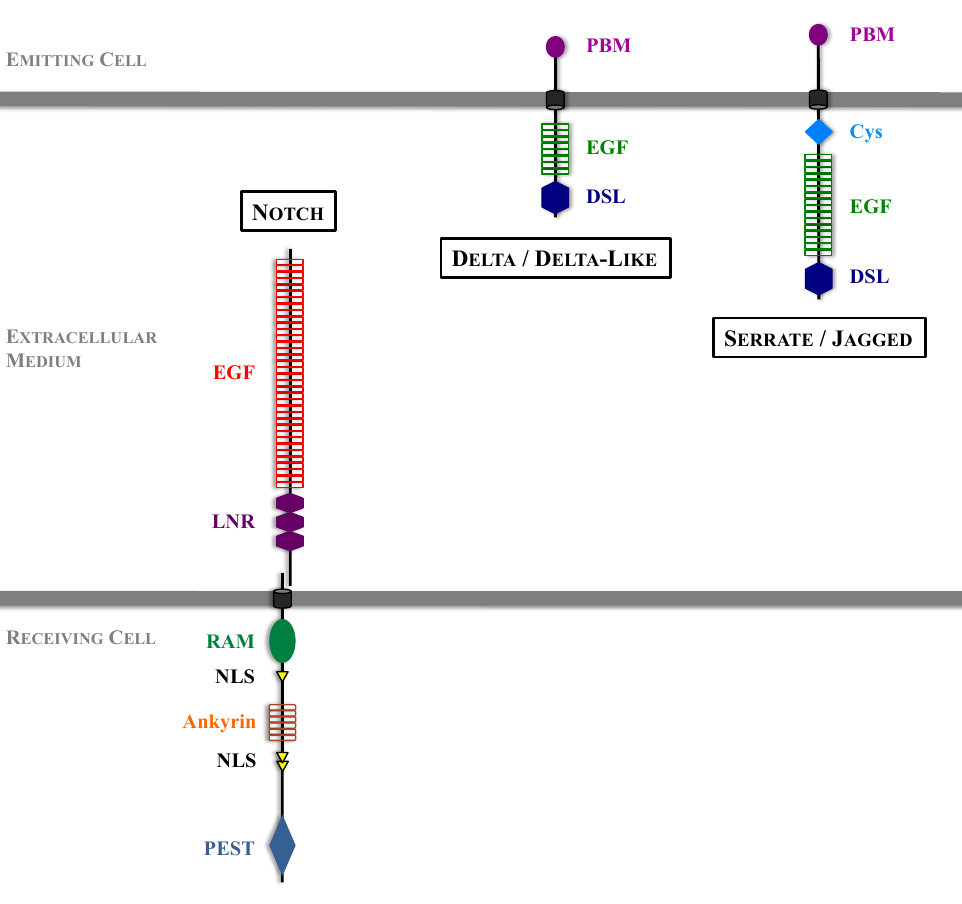
Figure 1. Structure of Notch receptor and DSL ligands. EGF: Epidermal Growth Factor-like repeats; LNR: Lin-12 Notch Region; RAM: RBPJ-Associated Molecule; PEST: Proline (P), Glutamic Acid (E), Serine (S) et Threonine (T); PBM: PDZ Binding Motif; DSL: Delta, Serrate, Lag-2; Cys: Cysteine.